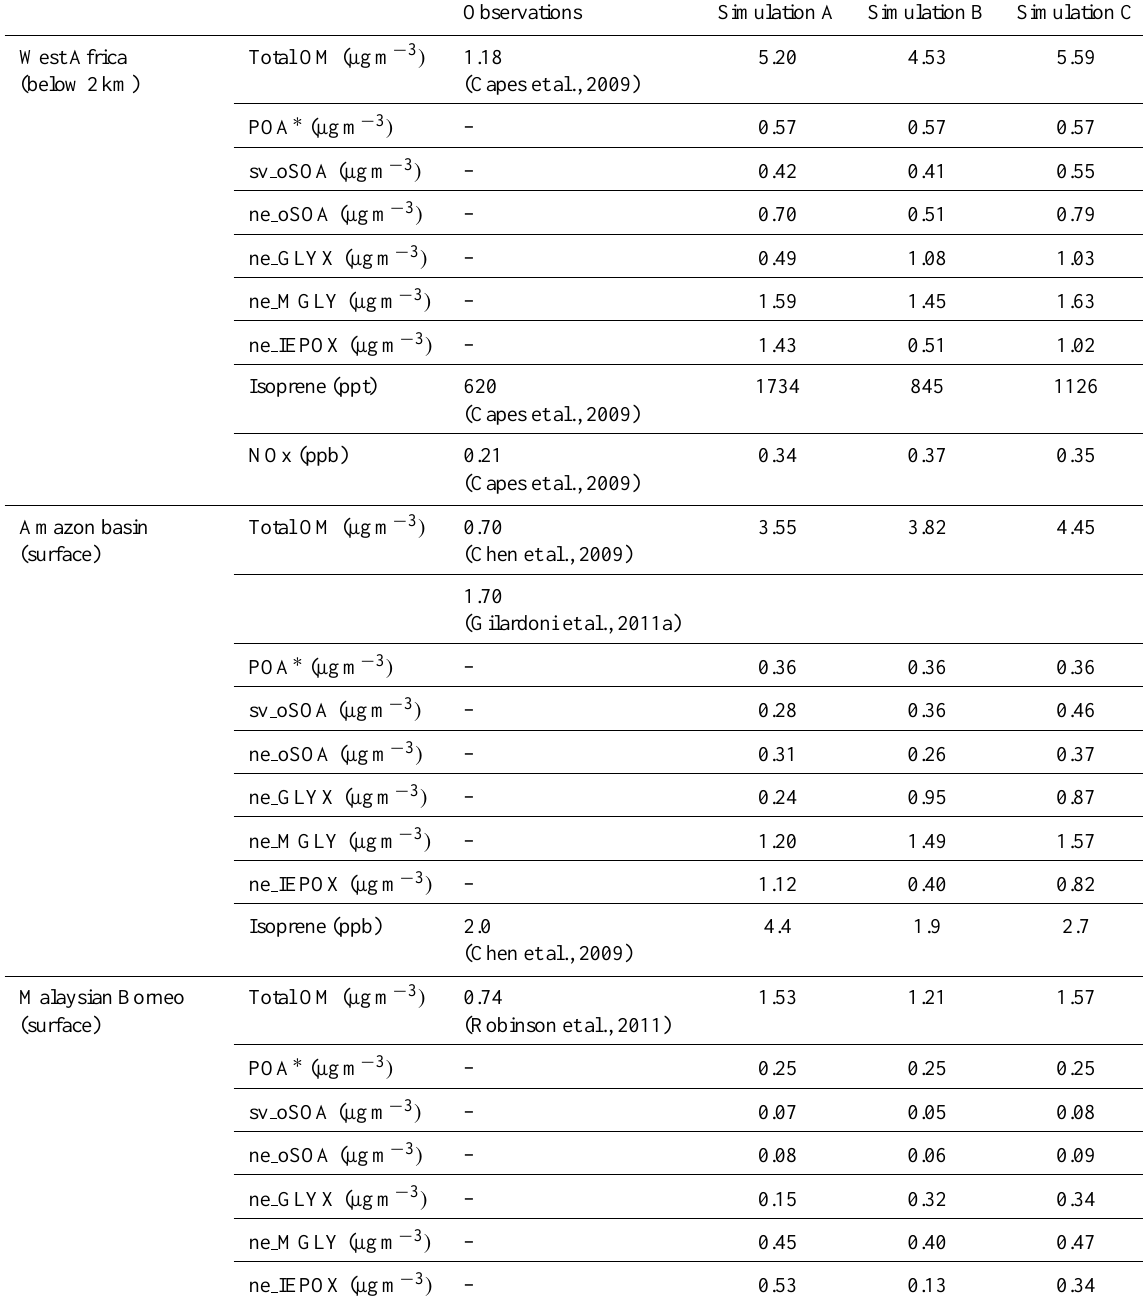
Table 9. Comparison of simulated OA with observed OA measured in tropical forested